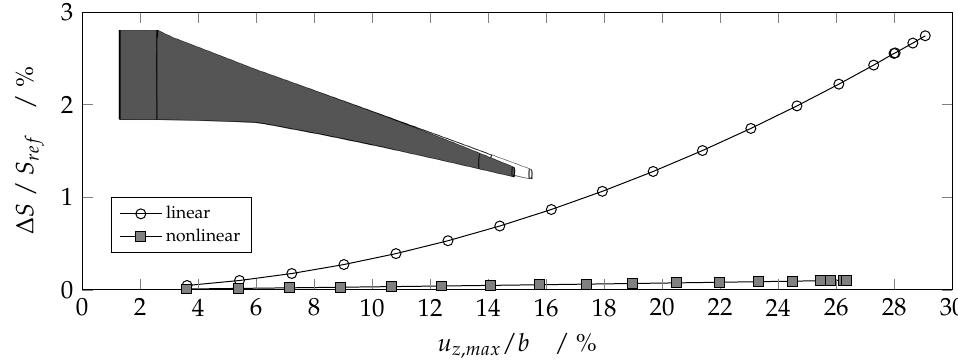
Figure 5. Relative change in lifting surface due to deformation-right wing [16].